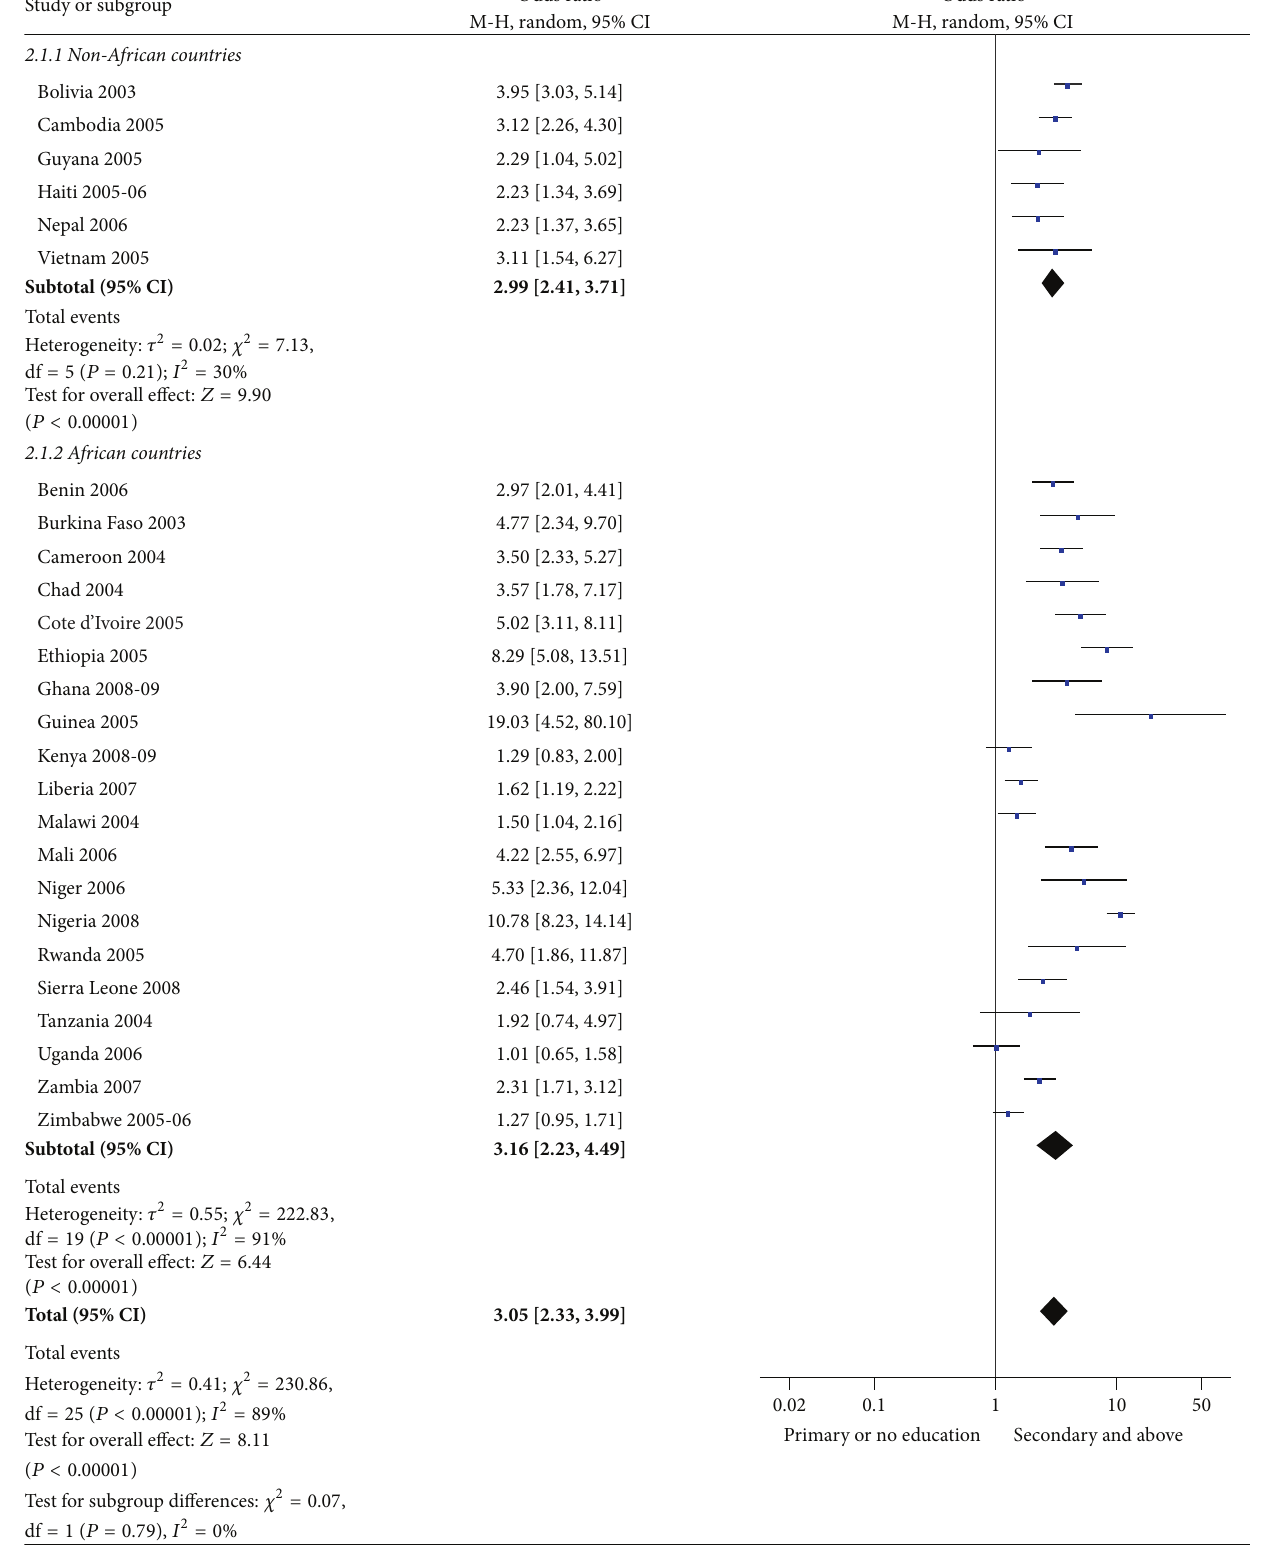
Figure 2: Higher-risk sex practices in past 12 months by educational attainment (2003–2009). M-H = Mantel-Haenszel statistic; CI = confidence